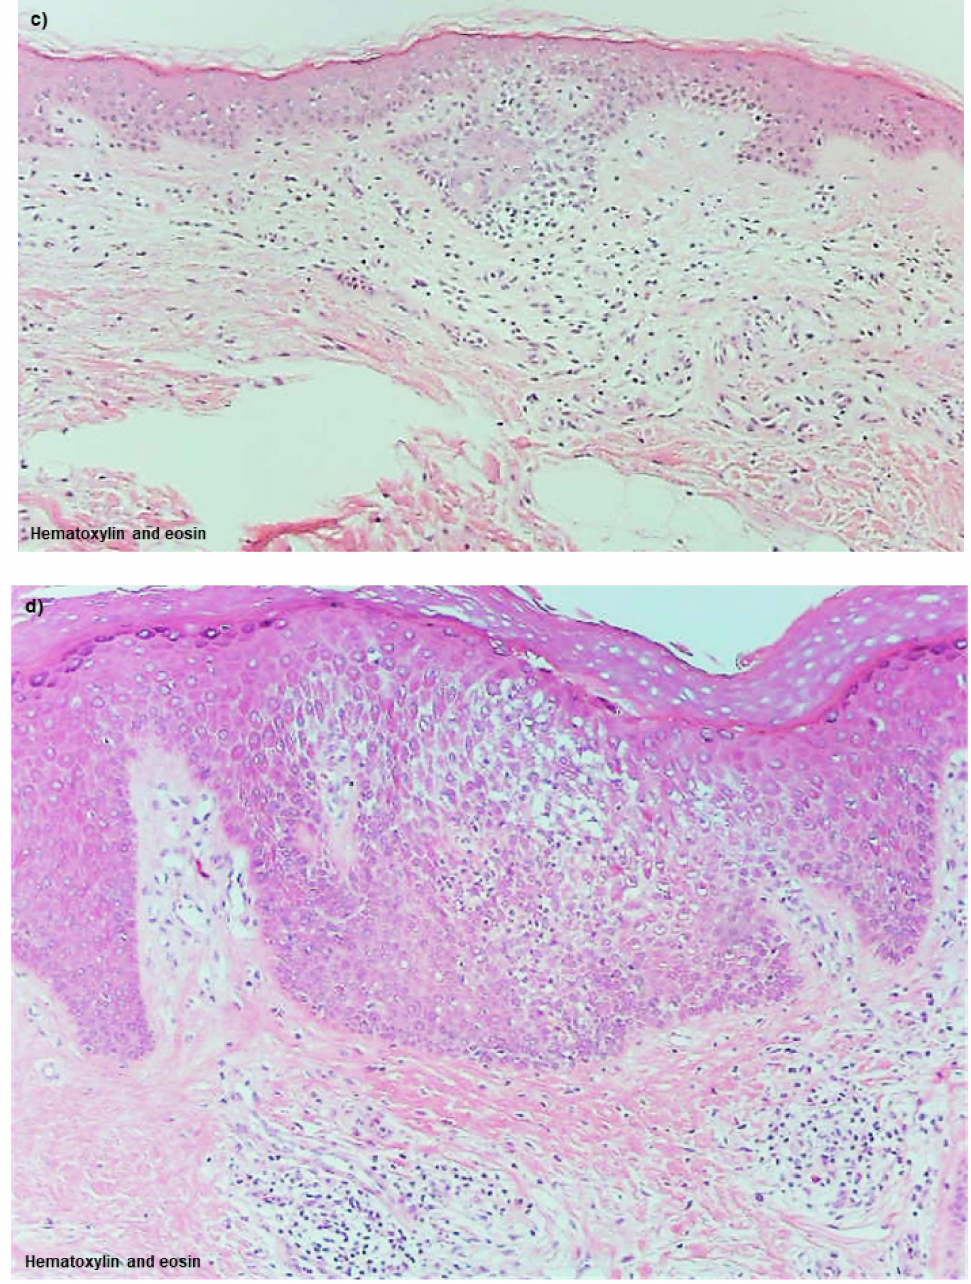
Figure 2. Histopathology of skin manifestations of IgE-allergic AD. ( a ). Uninvolved skin : No abnormal findings are observed by hematoxylin and eosin staining. ( b ). Lichenified eczema; non- spongiotic dermatitis : Epidermal hyperplasia with an irregular extension of the rete ridges, and dermal infiltration of lymphocytes and macrophages with increased MCs are observed. ( c ). Atopy patch test; spongiotic dermatitis : Focal spongiosis with infiltration of small round cells is observed in the middle to lower layers of the epidermis. ( d ). Lichenified eczema; spongiotic dermatitis : Focal spongiosis with infiltration of small round cells is observed in the acanthotic epidermis. Original magnifications: 100 × , ( a – d ). Characteristics of the patients shown the figures: the patient was a 61-year-old woman with an elevated serum total IgE level of 10,198 IU/mL and specific IgEs for Der f and Der p, ( a , b , d ); and the patient was an 84-year-old man with an elevated serum total IgE level of 19,757 IU/mL and specific IgEs for Der f and Der p ( c ). Abbreviations: AD, atopic dermatitis; Der f, Dermatophagoides farinae ; Der p, Dermatophagoides pteronyssinus ; IgE, immunoglobulin E; and MCs, mast